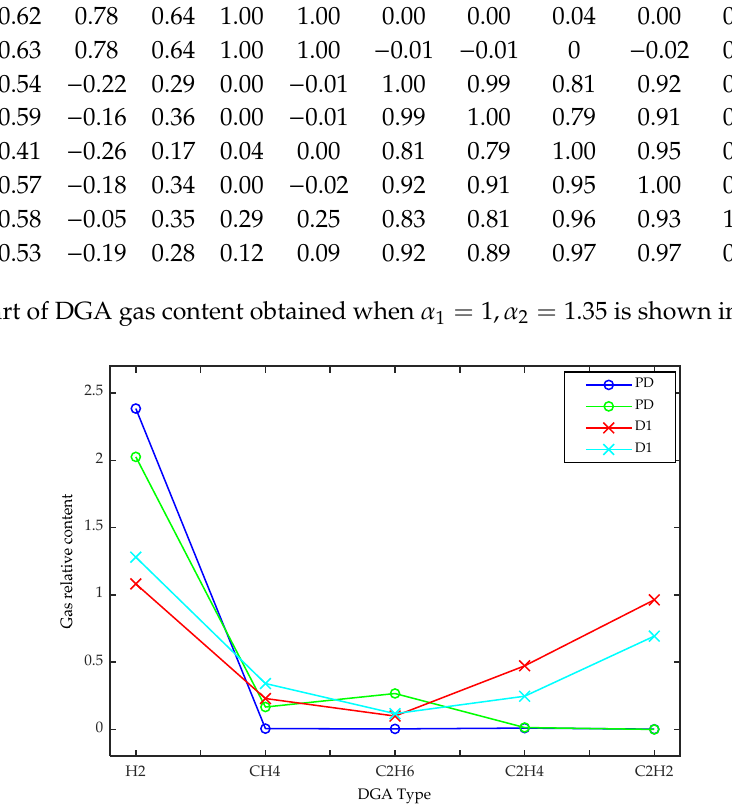
Figure 2. Line chart after gas content amplification.